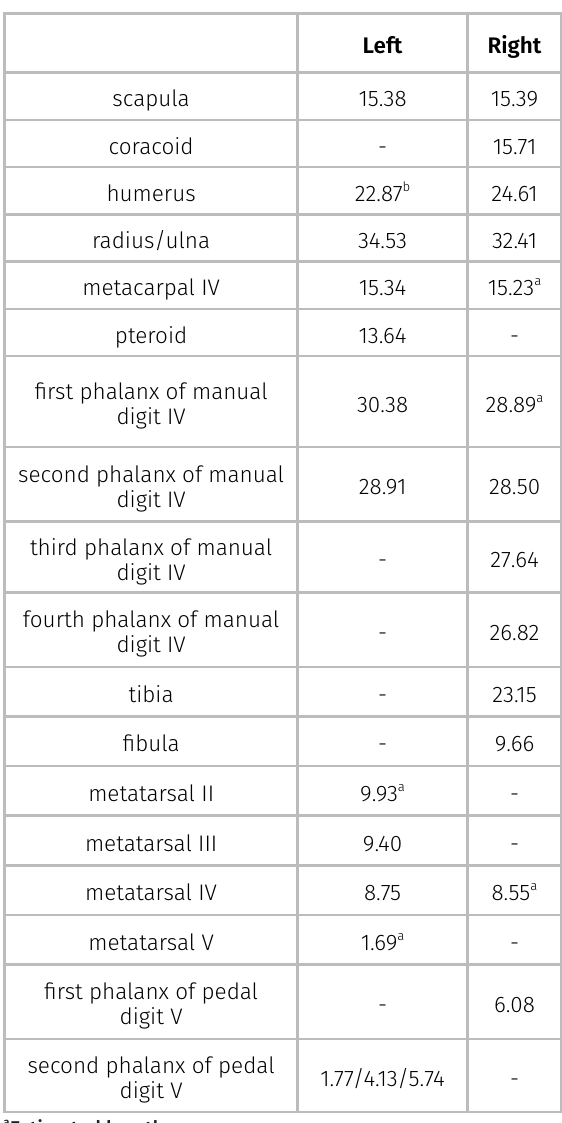
Table III. Measurements of postcranial elements in Kunpengopterus sinensis (STM 19-59) (in